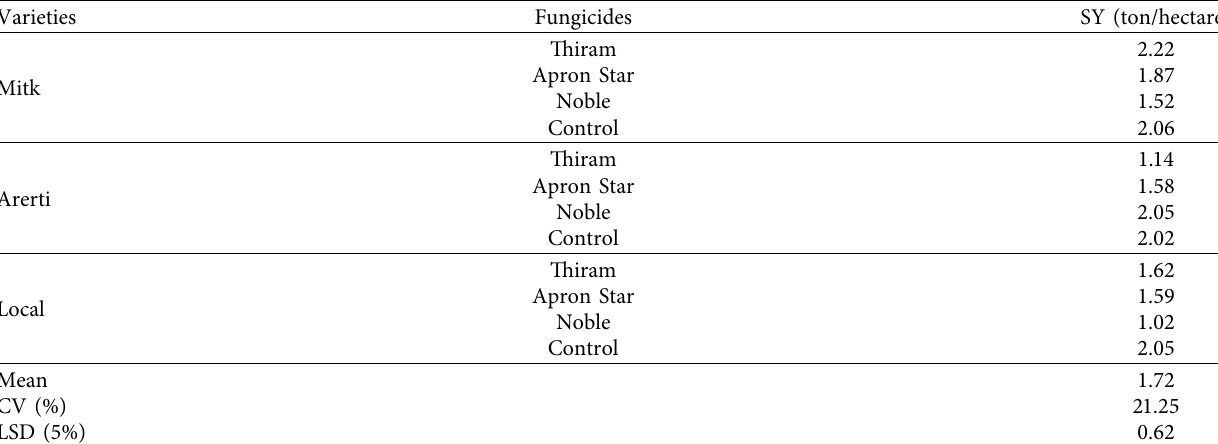
Table 2: Interaction effect of seed-dressing fungicides and chickpea varieties on seed yield of chickpea at woleh trial site. Varieties